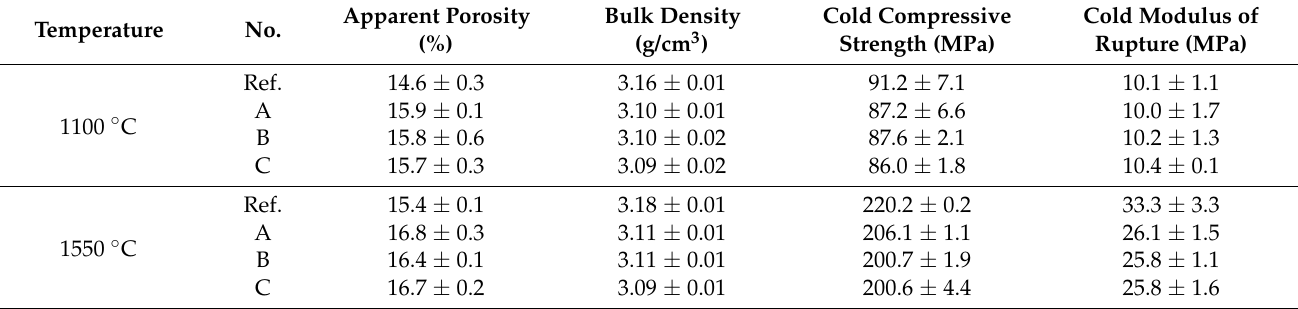
Table 4. Apparent porosity, bulk density, CCS and CMOR of samples calcined at different temperatures. Temperature No.